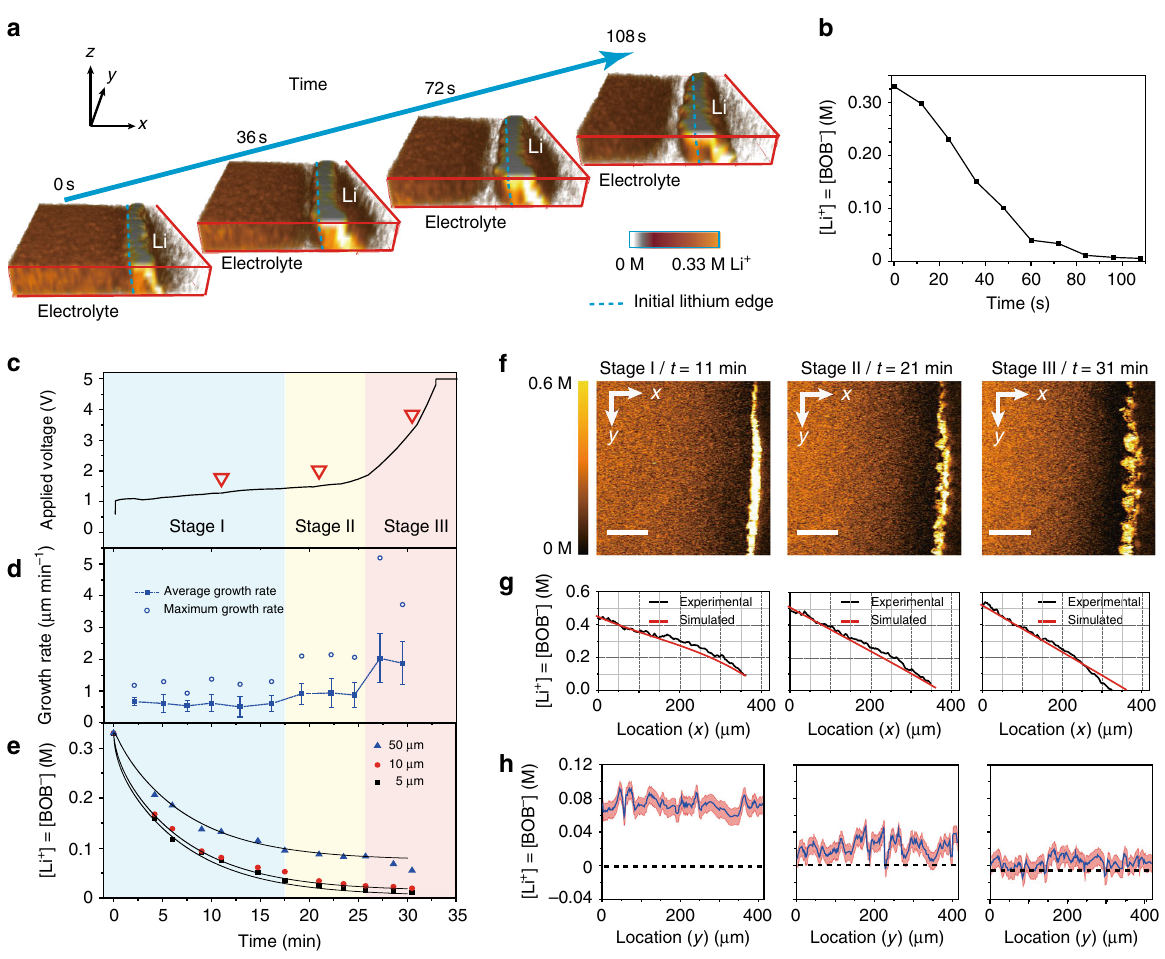
Fig. 3 Visualization of ion transport/depletion and dendrite growth on a 2D Li electrode. a 3D images showing depletion of ions near the Li surface at a current density of 4.2 mA cm − 2 . The expansion of the transparent area (white) near the Li electrode indicate gradual Li + -ion depletion in the vicinity of the electrode. The imaging area is 150 μ m ( x ) × 250 μ m ( y ) × 50 μ m ( z ), and the area is stretched by 66.7% along the x -axis to amplify the Li growth. b Average Li + concentration 5 μ m away from the Li surface in a . c Voltage pro fi le of a Li/Li symmetric cell at 1.3 mA cm − 2 . d Li growth rate and standard deviation vs. time. The solid and empty squares represent the average growth rate ( v ave ) and the maximum local growth rate ( v max ). e Average [Li + ] vs. time at 5 μ m, 10 μ m and 50 μ m away from the electrode surface. Black lines are the fi tting curves based on the Nernst – Planck equation. f Representative 2D SRS images at 11 min, 21 min and 31 min. The color bar on the left represents the [Li + ] in the electrolyte. Scale bars are all 100 μ m. g 1D [Li + ] pro fi le along the x -direction of the SRS 2D images in f (black lines). Red lines are the simulation results based on the Nernst – Plank equation. h Extrapolated [Li + ] on the Li surface ([Li + ] 0 μ m ) along the electrode contour versus the location ( y -direction). The value is determined by a linear extrapolation of all the points between [Li + ] 10 μ m and [Li + ] 3 μ m (Supplementary Fig. 10). The error bar in f is ±10 mM. All [Li + ] in this study were measured based on [BOB – ], and